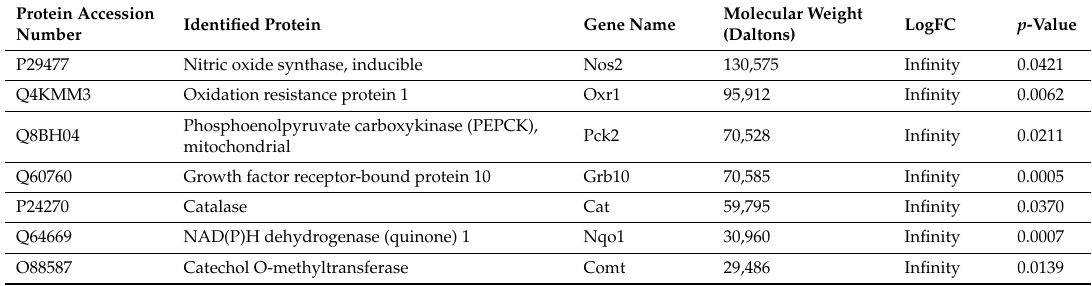
Table 1. Altered di ff erential protein spots in the PLum-AI cells vs. PLum-AD cells. A total of 99 altered di ff erential protein spots were identified in PLum-AI cells as compared to PLum-AD cells